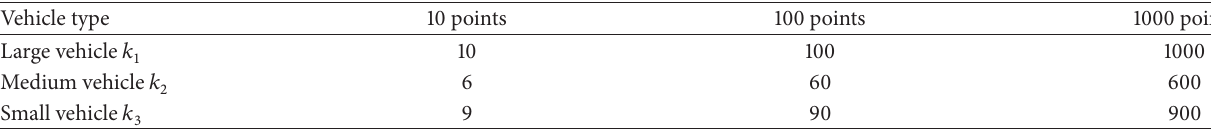
Table 1: Required number of vehicles.